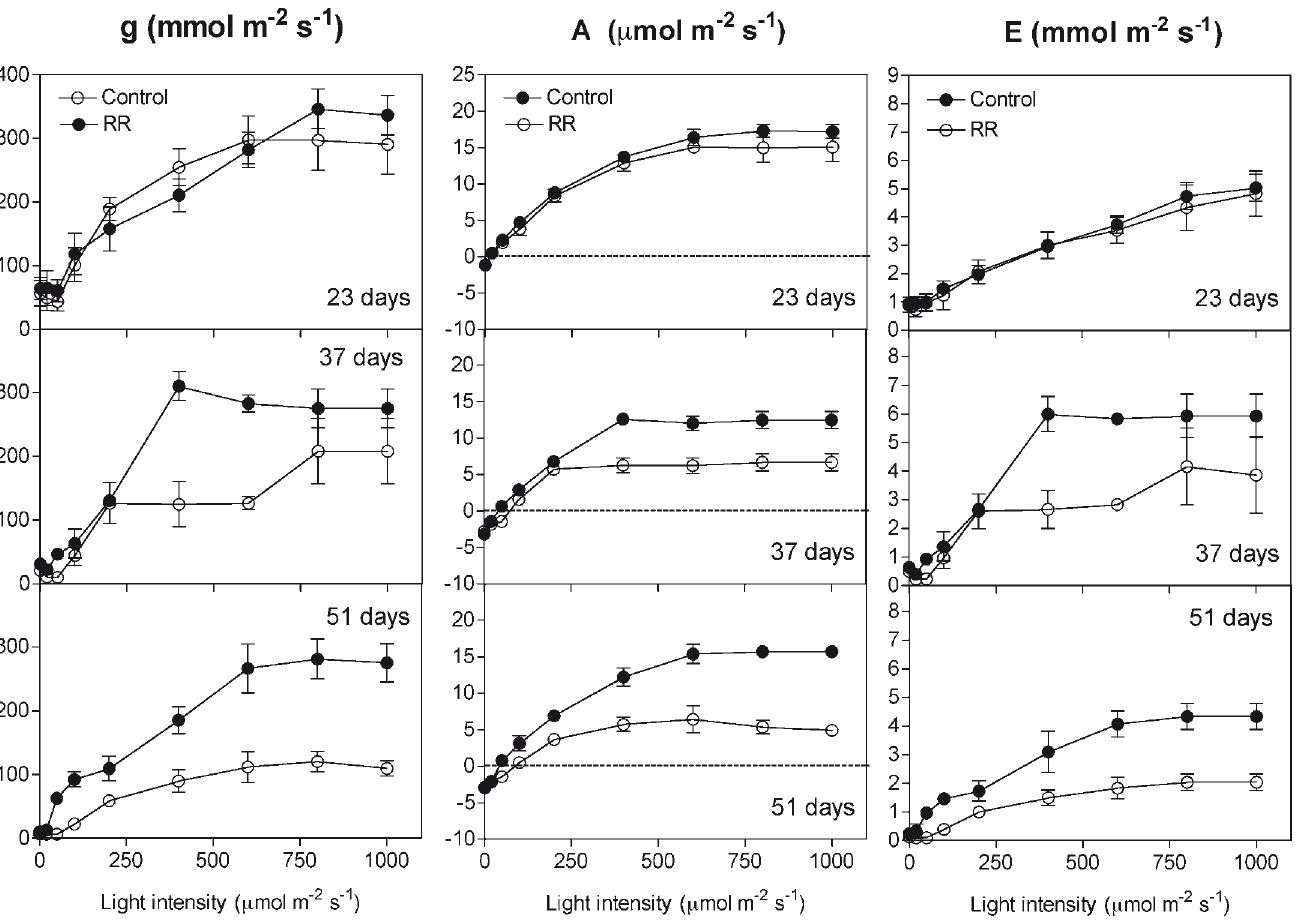
3 - Light saturation curves for the three leaf gas exchange parameters ( g , A and E) measured every two weeks from day 23 to the end of the experiment in both control and root-restricted (RR)